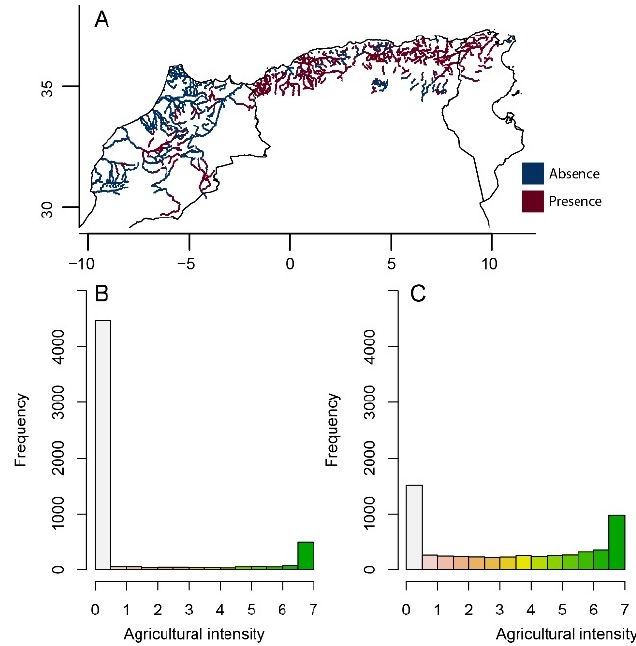
Figure 6. Predicted geographic range of Platycnemis subdilatata and the intensity of agriculture in North African lotic habitats. ( A ) Geographic range of P. subdilatata derived from species distribution modelling restricted to the main North African rivers, based on the ensemble model of 11 algorithms. The frequency distribution of agricultural intensity in 1992 ( B ) and 2005 ( C ) around (2 km buffer) the portion of the watercourse where the species lives. Note the abrupt decline in the frequency of low agricultural intensity and the increase in the frequency of the other intensities from 1992 to